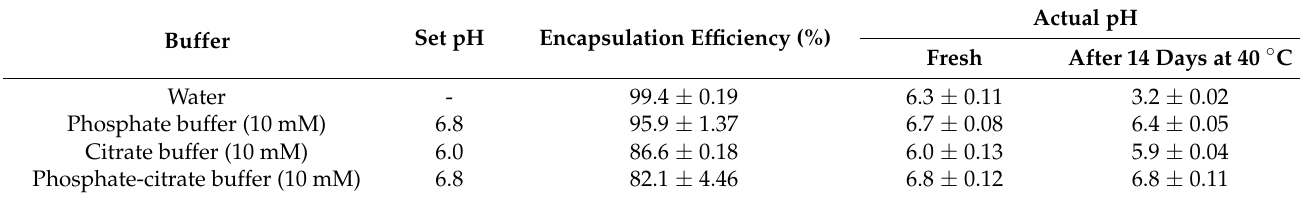
Table 1. Encapsulation efficiency (%) and pH of liposome suspensions prepared in various aqueous phases with 0.2 mM FeSO 4 . Values are the average ± standard deviation of three measurements done on two independently prepared batches. Actual pH Buffer Set pH Encapsulation Efficiency (%) Fresh After 14 Days at 40 ◦ C Water - 99.4 ± 0.19 6.3 ± 0.11 3.2 ± 0.02 Phosphate buffer (10 mM) 6.8 95.9 ± 1.37 6.7 ± 0.08 6.4 ± 0.05 Citrate buffer (10 mM) 6.0 86.6 ± 0.18 6.0 ± 0.13 5.9 ± 0.04 Phosphate-citrate buffer (10 mM) 6.8 82.1 ± 4.46 6.8 ± 0.12 6.8 ±